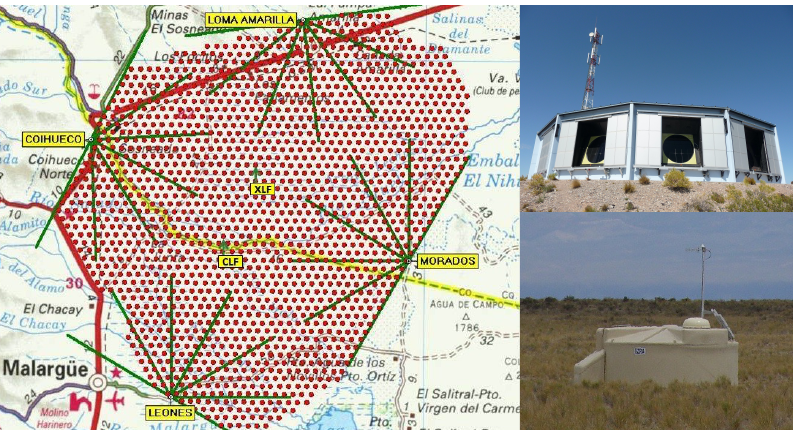
Figure 2. Left : map of the Pierre Auger Observatory [17]; each dot represents one SD station; the four FD sites at the border of the SD array are also shown. Top right : the fluorescence telescopes at the FD site Los Leones; even though the picture was taken during the daytime, the shutters were had been opened for maintenance. Bottom right : a single SD station in the Pampa Amarilla